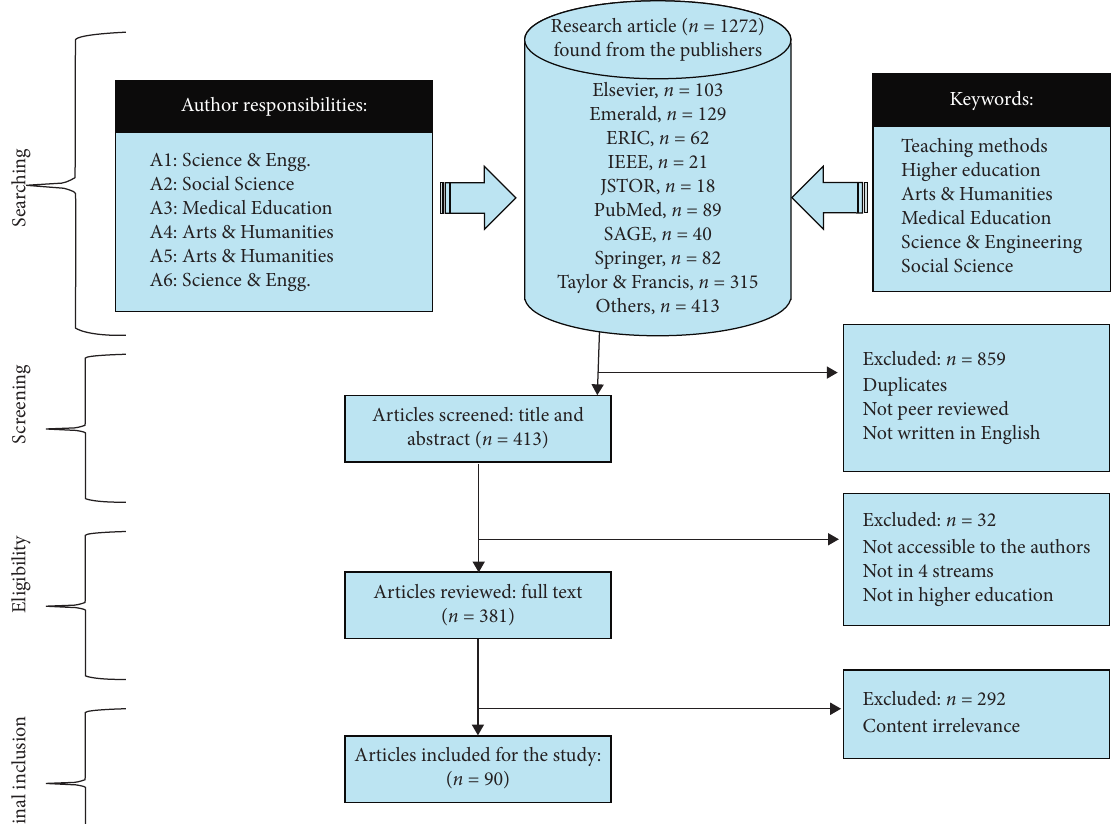
Figure 1: Review